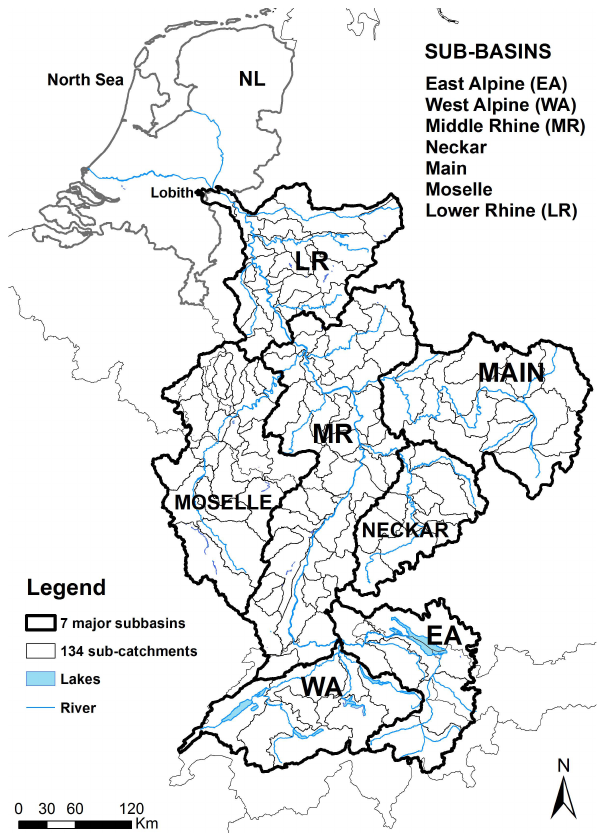
Fig. 1. Schematisation of the 134 sub-catchments (spatial scale of HBV model) and seven major sub-basins of the River Rhine up- stream of